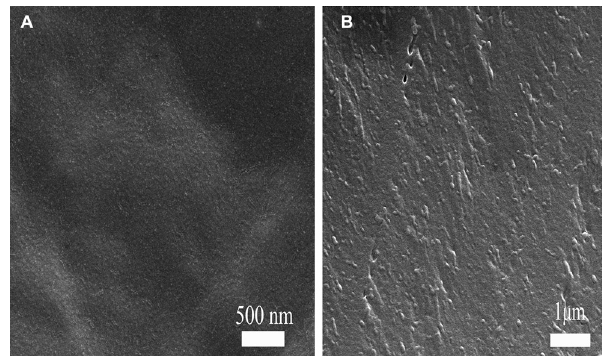
Figure 3 FESEM for the section microstructure of (A) polyurethane and (B) grafted epoxy resin.